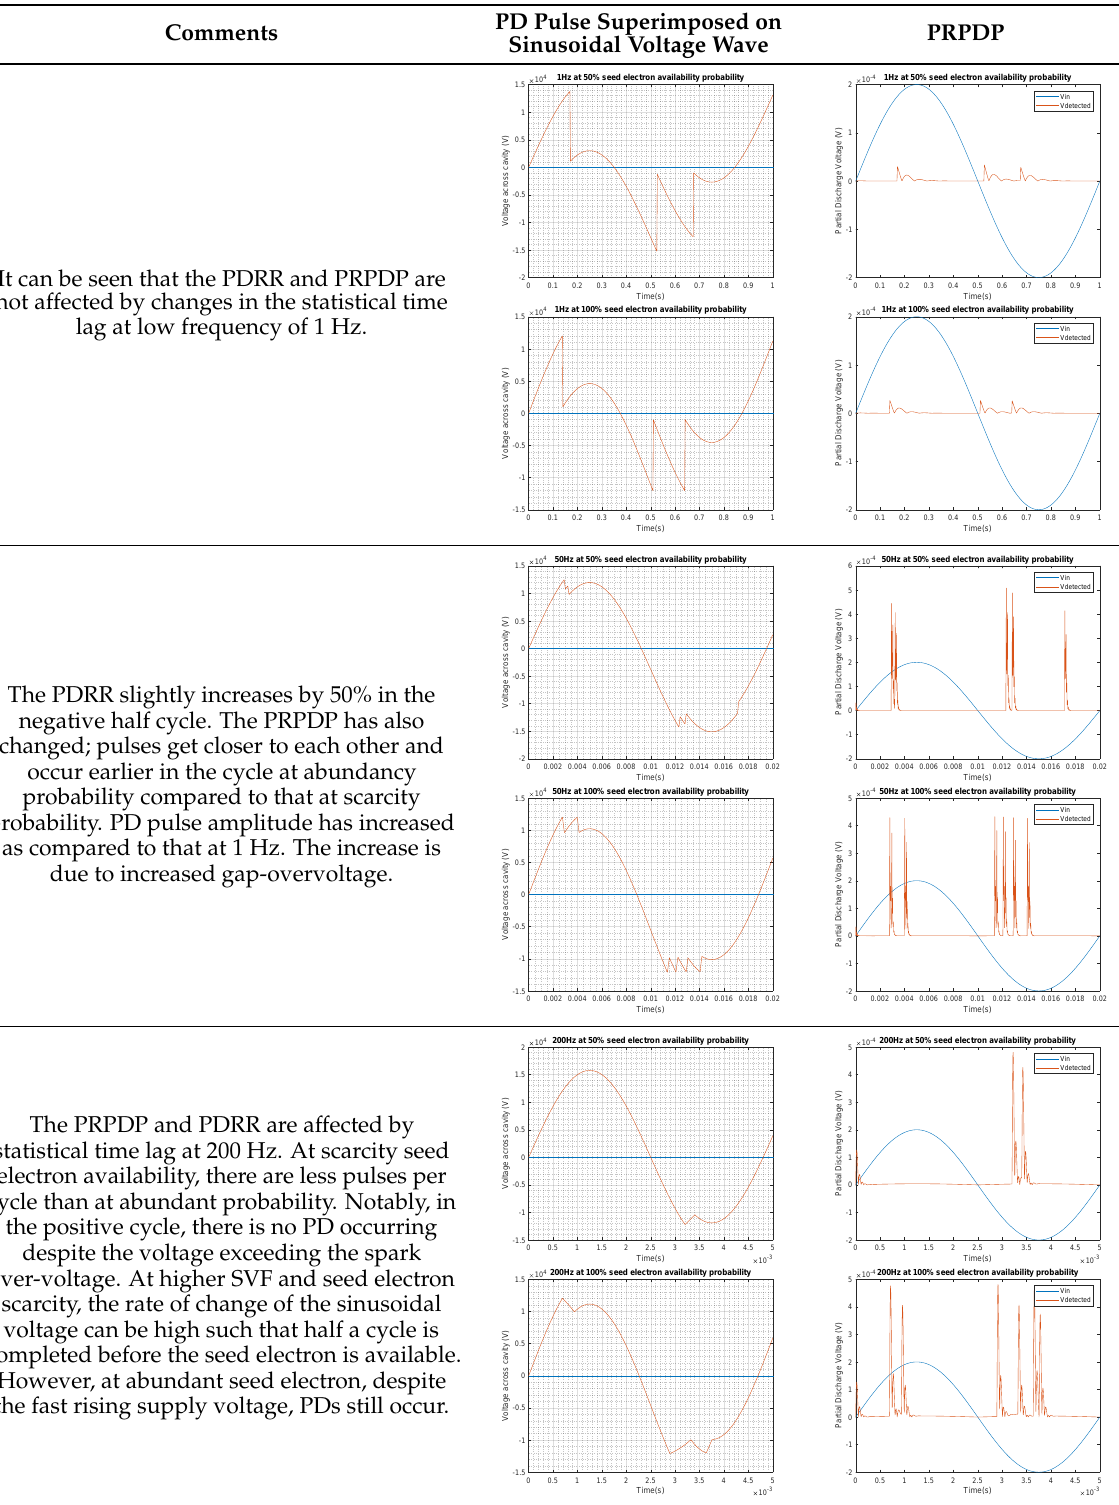
Table 4. Statistical time lag influence on PD characteristics at different